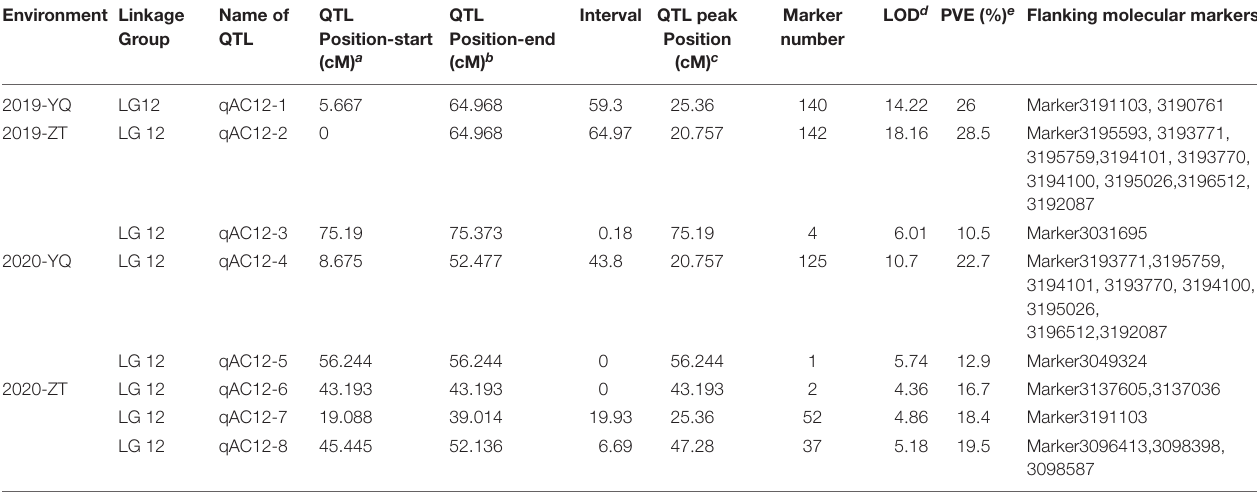
TABLE 5 | Summary of QTLs identified in this